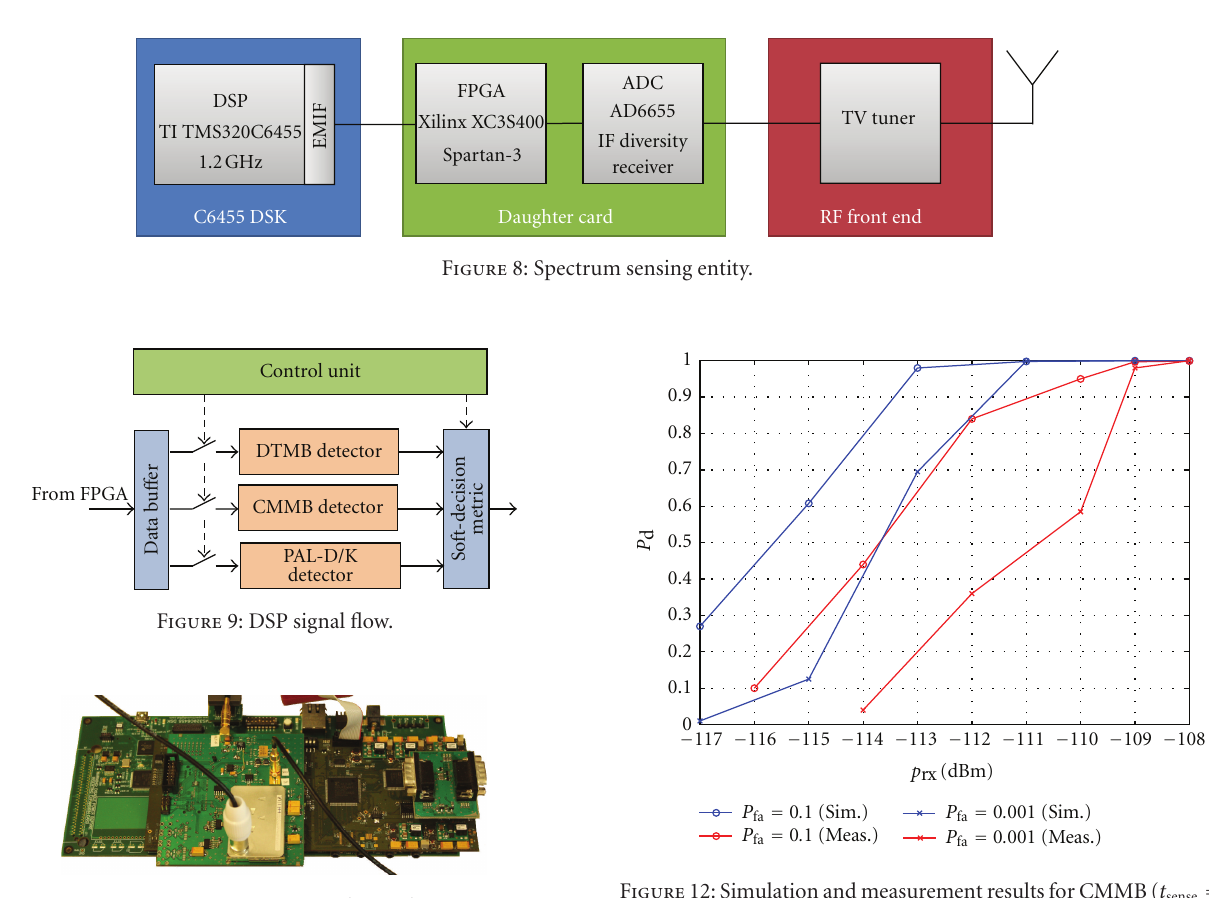
Figure 10: Spectrum sensing entity.